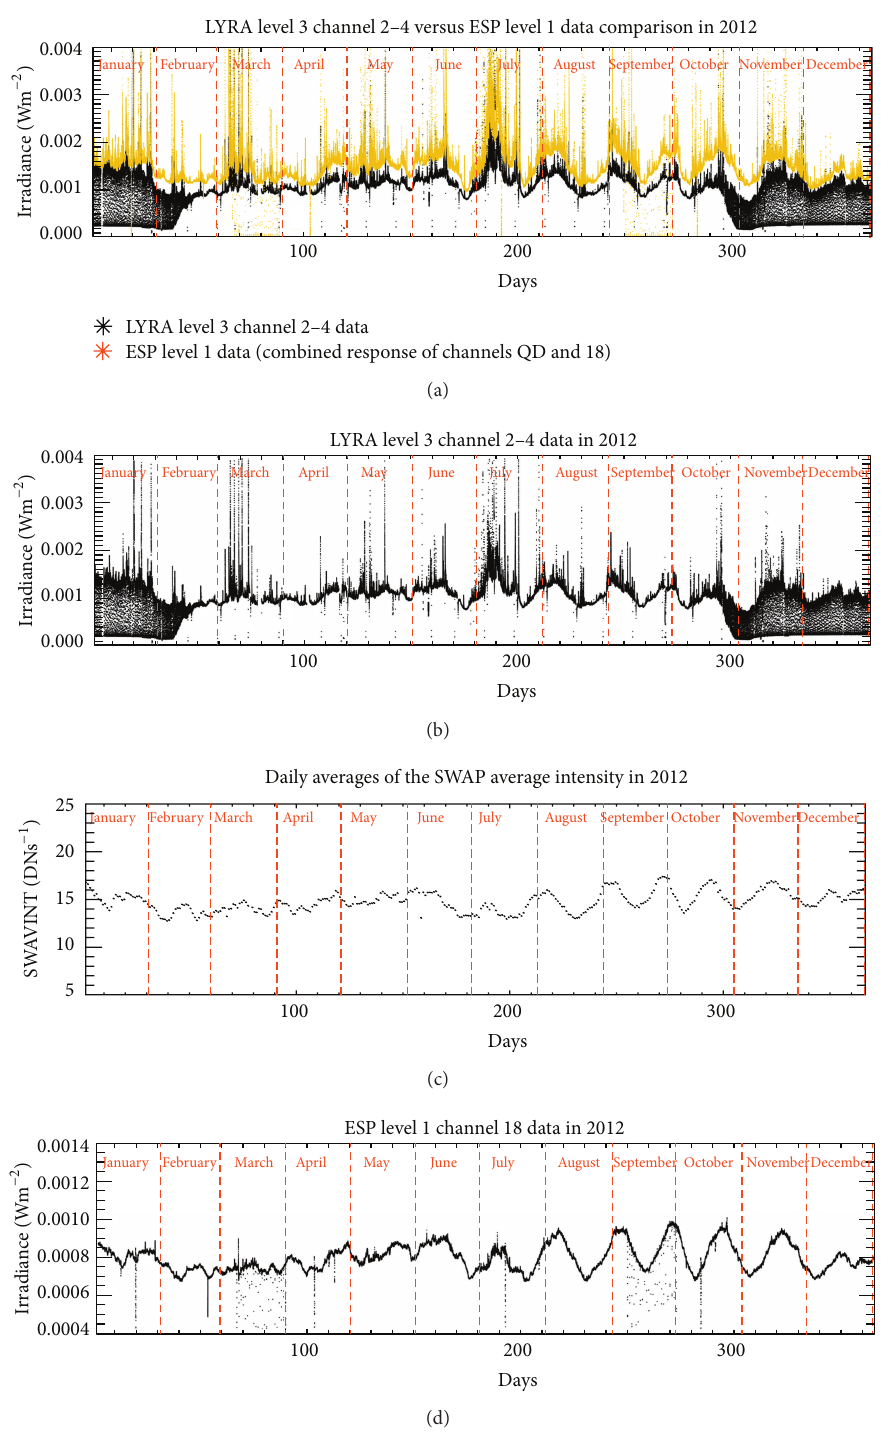
Figure 3: From top to bottom: LYRA level 3 channel 2–4 and ESP level 1 data (at combined responses of the channels QD and 18); LYRA channel 2–4 data alone; daily averages of SWAVINT data; and ESP channel 18 data variations in